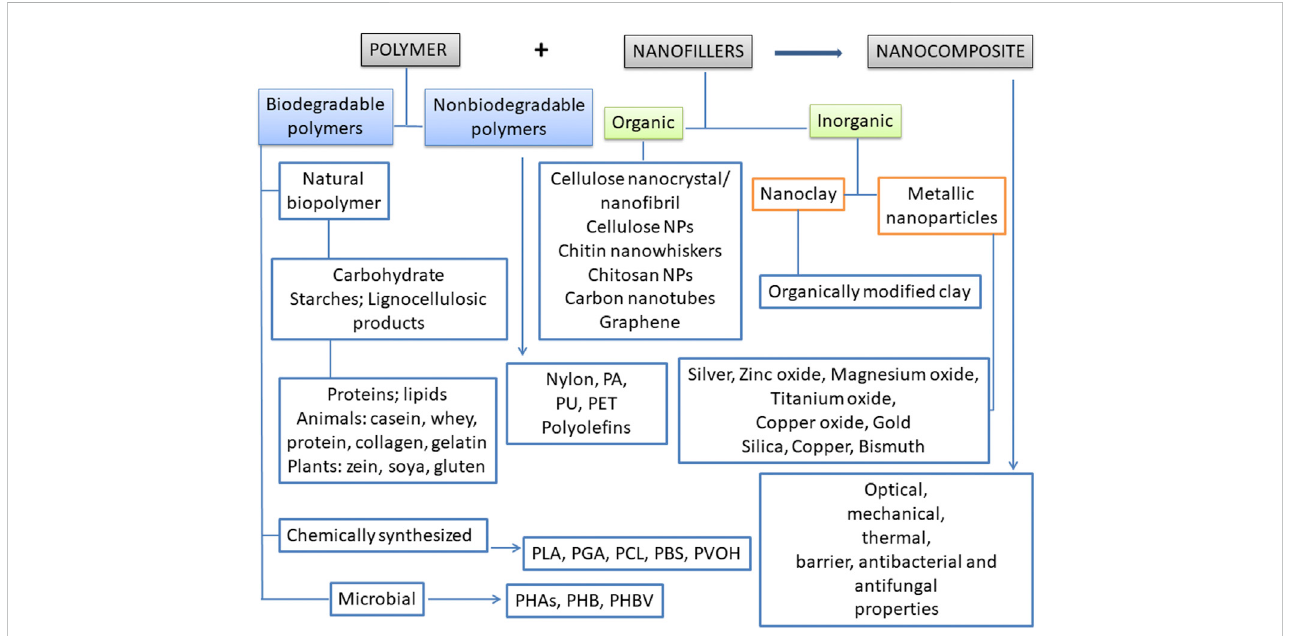
FIGURE 1 Polymer-nanocomposite structures. PA, Polyamide/Nylon; PBS, Polybutylene succinate; PCL, Polycaprolactone; PET, Polyethylene terephthalate; PGA, Polyglycolic Acid; PHAs, Polyhydroxyalkanoates; PHB, Polyhydroxybutyrate; PHBV, Poly (3-hydroxybutyrate-co-3-hydroxyvalerate); PLA, Polylactic acid; PU, Polyurethane; PVOH, Polyvinyl Alcohol.